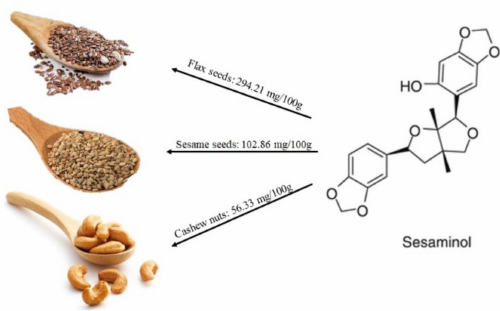
Figure 2. Main foods containing lignans, mostly sesaminol, according to the database Phenol-Explore (http: // phenol-explorer.eu / ).